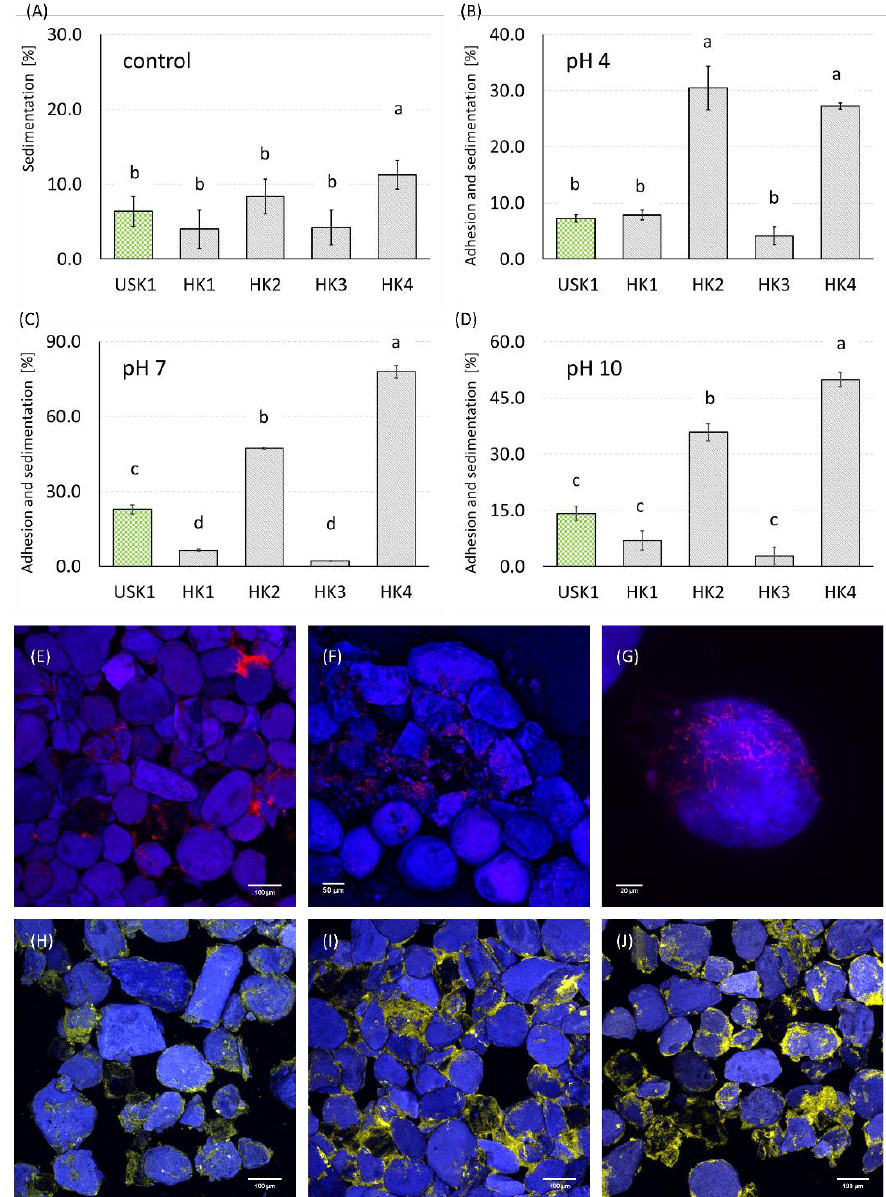
Figure 5. Adhesion or/and sedimentation ( A – D ) of selected native bacteria and Bacillus subtilis USK1 (served as a reference strain) onto ore from Djebel Onk after incubation at various pH, and adhesion of reference USK1 strain ( E – G ) or native strain ( H – J ) onto the ore particle surface. Microorganisms were labeled with quantum dots: red — USK1 and yellow — HK4. The same letter (a, b, c) in a partic- ular pH denotes no significant differences among strains.